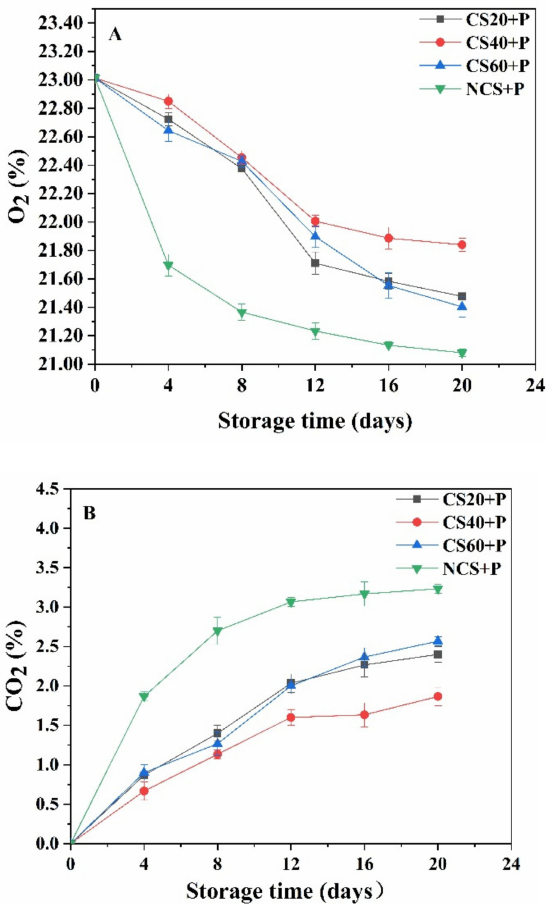
Figure 1. Changes in O 2 ( A ) and CO 2 ( B ) content during storage at 13 ± 2 ◦ C in different treat- ments. CS20+P − packaged after 20 min of cold shock; CS40+P − packaged after 40 min of cold shock; CS60+P − packaged after 60 min of cold shock; NCS+P − packaged after 0 min of cold